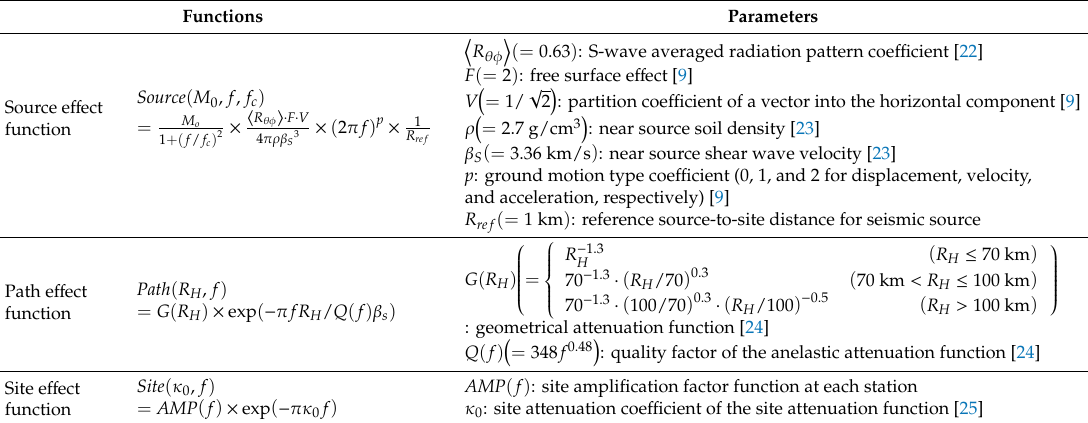
Table 2. Information about the functions and component parameters of the stochastic point-source